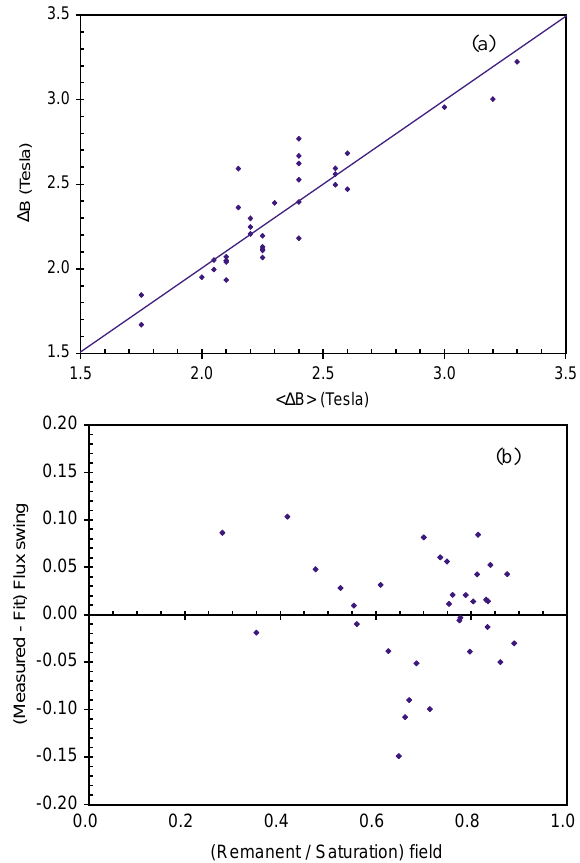
FIG. 7. (Color) (a) Flux swing from Eq. (5) versus the measured flux swing, data from Tables II and III. (b) Difference between measured and Eq. (5) flux swing versus the ratio of the remanent to saturation magnetic